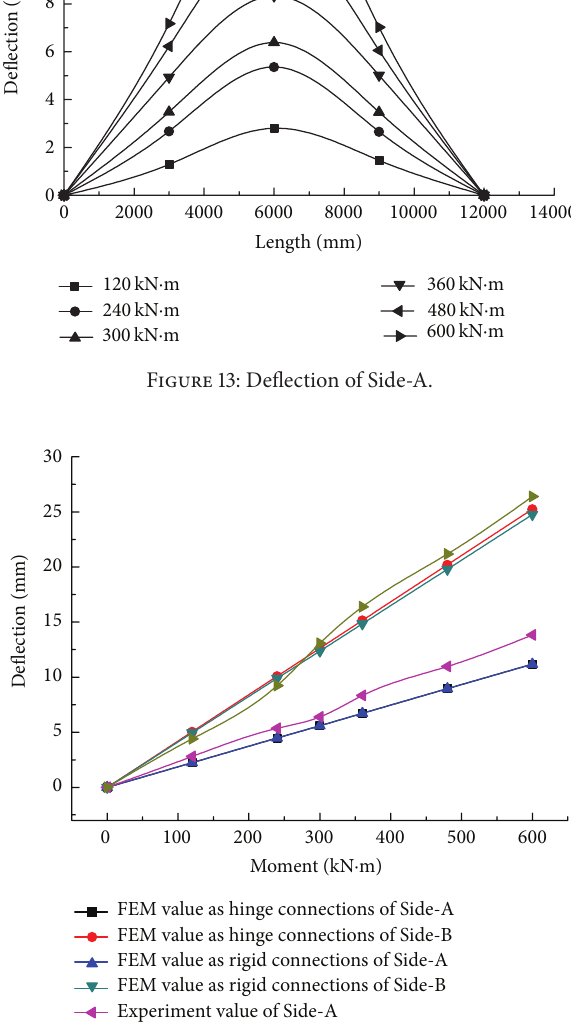
Figure 14: Finite element calculated values and the experimental values of deflection in the midspan for both